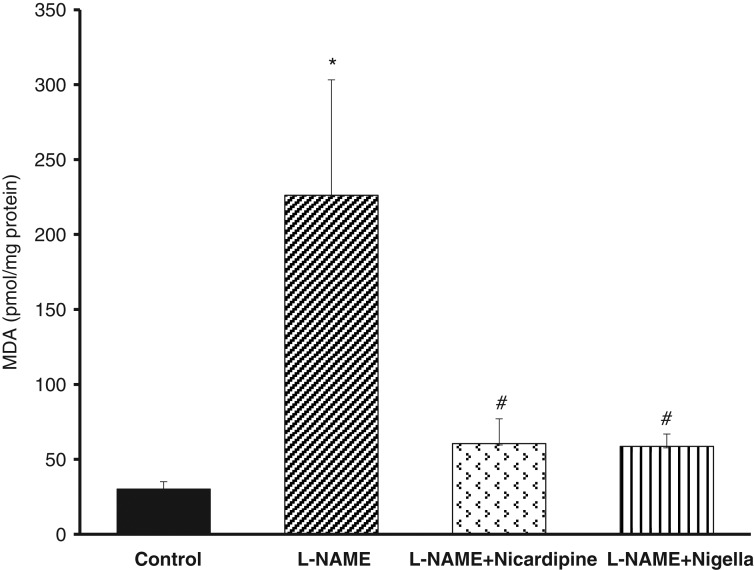
Effect of N. sativa oil on heart lipid peroxidation product in rats administered L-NAME for 8 weeks. The bars represent the mean±SEM (n=6). *p<0.01 versus control, # p<0.05 versus L-NAME.